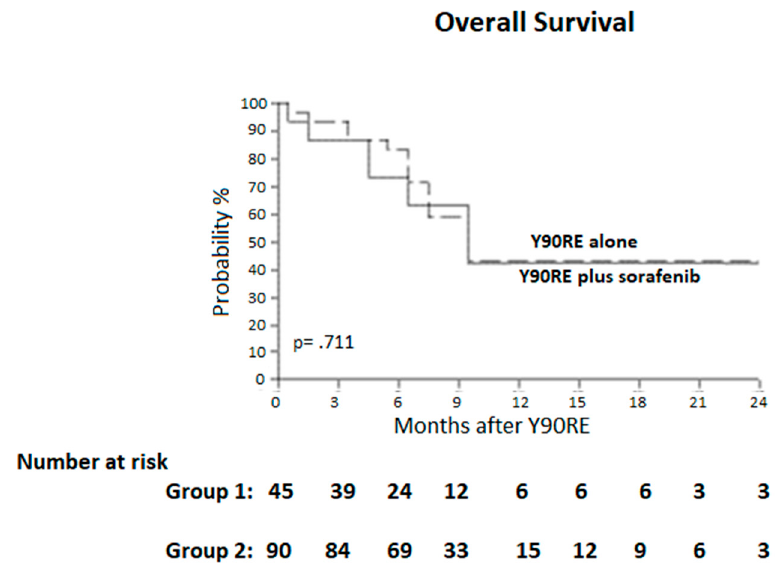
Figure 2. Overall survival curves. Median survival was 10 months (7–12) and 10 months (8–11), in the two groups. Y90RE, Yttrium 90